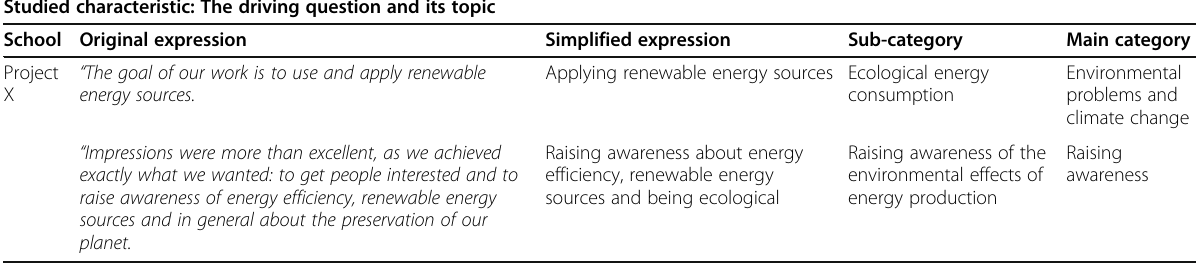
Table 3 An example of the coding combining inductive and deductive content analysis Studied characteristic: The driving question and its